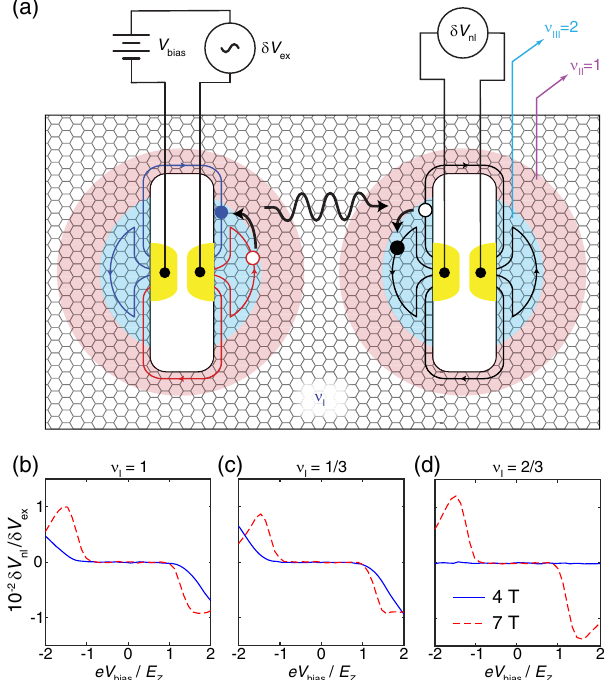
FIG. 3. Electrically detected magnon transmission in the frac- tional quantum Hall regime. (a) Schematic of magnon trans- mission experiment on device A. (b) Nonlocal response as 1 , B 4 and 7 T. Curves function of bias voltage V at ν ⊥ ¼ bias I ¼ are acquired at a nominal temperature of 70 mK. (c) Same as (b), 1 = 3 . (d) Same as (b), (c), measured at ν 2 = 3 . measured at ν I ¼ I ¼ FIG. 4. Contrasting magnon transmission in spin polarized fractional quantum Hall states. (a) Nonlocal response as function =E < 2 of the bottom gate voltage V and eV for 0 < ν B Z bias I measured at B ¼ 4 T and nominal temperature T ¼ 50 mK. (b) Comparison of the root-mean-square average of the data in (b) (red, dashed line) and the local bulk conductance (blue, solid 1 = 3 ; 5 = 3 line) as a function of V . (c) Nonlocal response at ν B I ¼ =E and as a function of eV , extracted from data in (a). Z bias 2 = 3 ; 4 = 3 . (e) In-plane field (d) Same as (c), measured at ν I ¼ dependence of thermally activated conductance of fractional quantum Hall states at ν ¼ 1 = 3 and 2 = 3 . The values of perpendicular magnetic field ( B ⊥ ) and total magnetic field ( B ) are labeled. The measurements were performed at T ¼ tot 1 . 6 K so that the gaps are thermally excited. (f) Same as (e), measured at ν ¼ 4 = 3 and 5 = 3